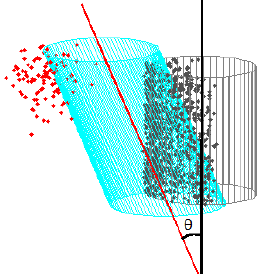
Figure 3. Illustration of bias orientation 𝜃 , i.e., angle between real cylinder (grey) axis and fitted cylinder (cyan) axis. Black dots are cylinder points and red points are